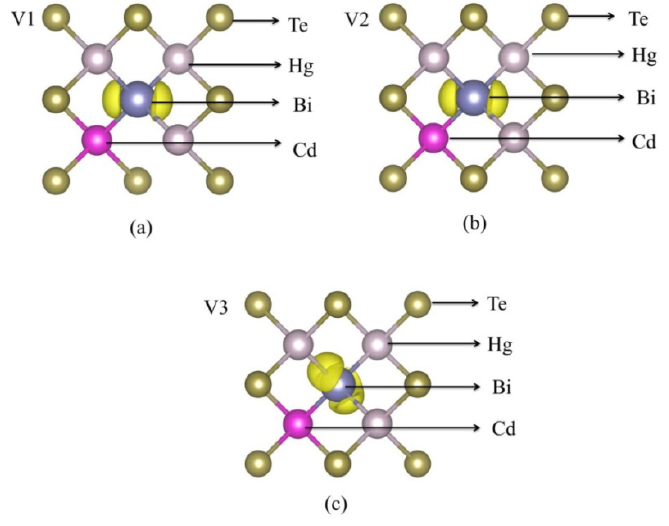
Figure 6. The band decomposed charge density of ( a ) V1, ( b ) V2, ( c ) V3, isosurfaces correspond to 0.003 e/Å.